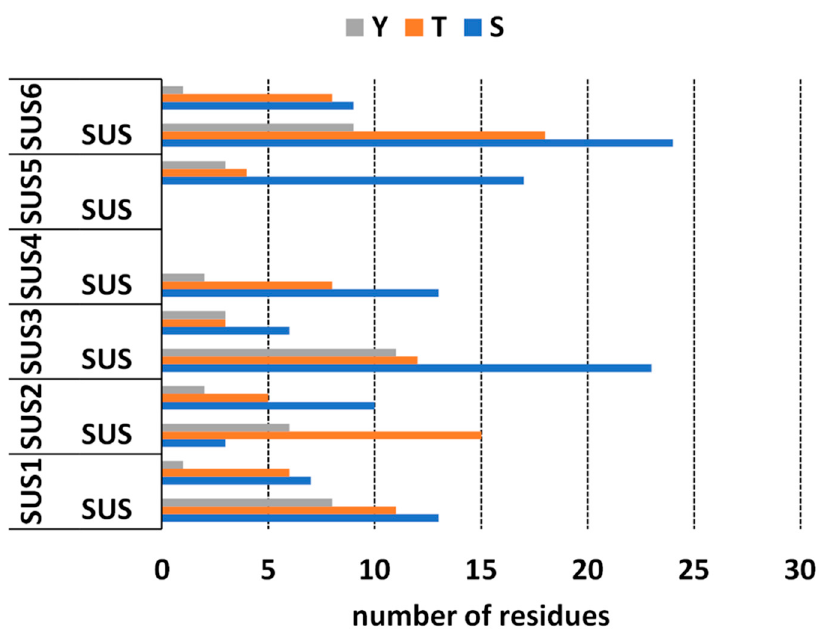
Figure 5. The predicted phosphorylation sites of UdSUS proteins. SUS = Sucrose synthase domain; Y= tyrosine; T= threonine; S= serine. Y = tyrosine; T = threonine; S =